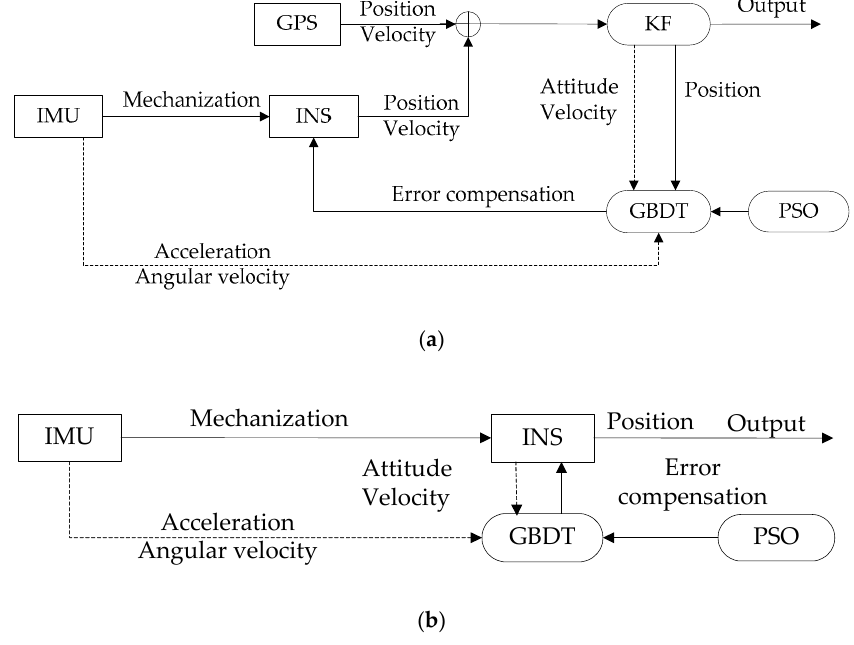
Figure 2. KGP prediction model diagram: ( a ) training mode and ( b ) prediction mode.